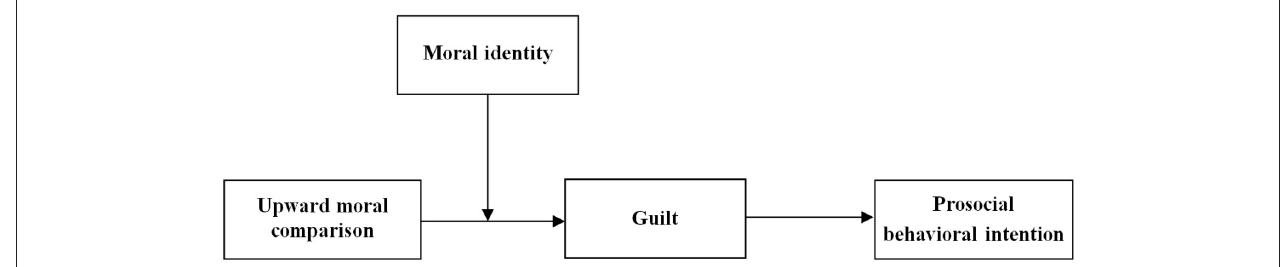
FIGURE 1 | Conceptual framework for the